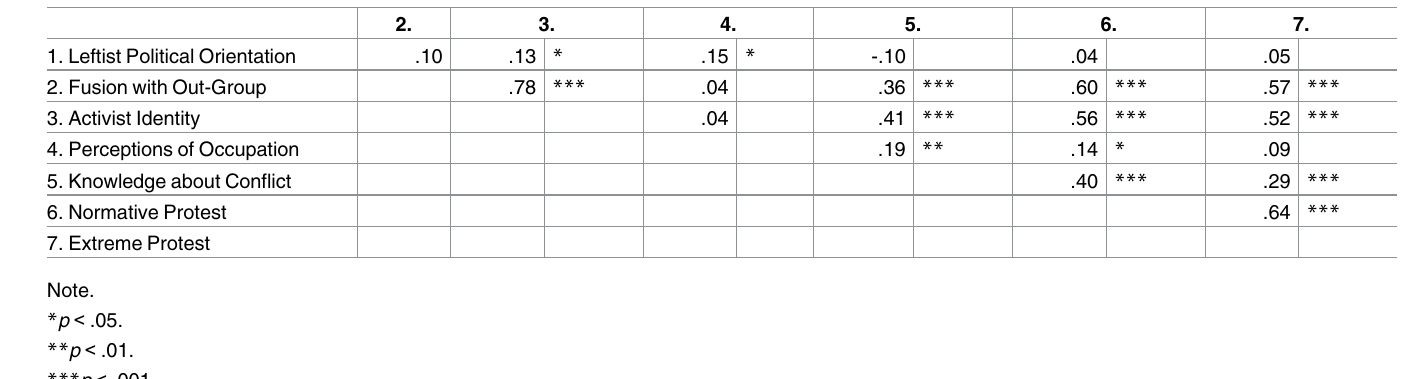
group, when the Kurds were described as victims of oppressive occupation but not when they were described as part of a war. Because the macro does not provide standardized coefficients and p values for indirect effects, we present unstandardized coefficients with upper and lower 95% confidence intervals here. As predicted, bootstrapping showed that leftist political orien- tation had significant and positive indirect effects on normative ( B = .08, SE = .04, 95% CI [.03, .19]) and extreme protest ( B = .08, SE = .03, 95% CI [.03, .15]) when the Kurds were described as victims of oppressive occupation, while the indirect effects were non-significant in the war